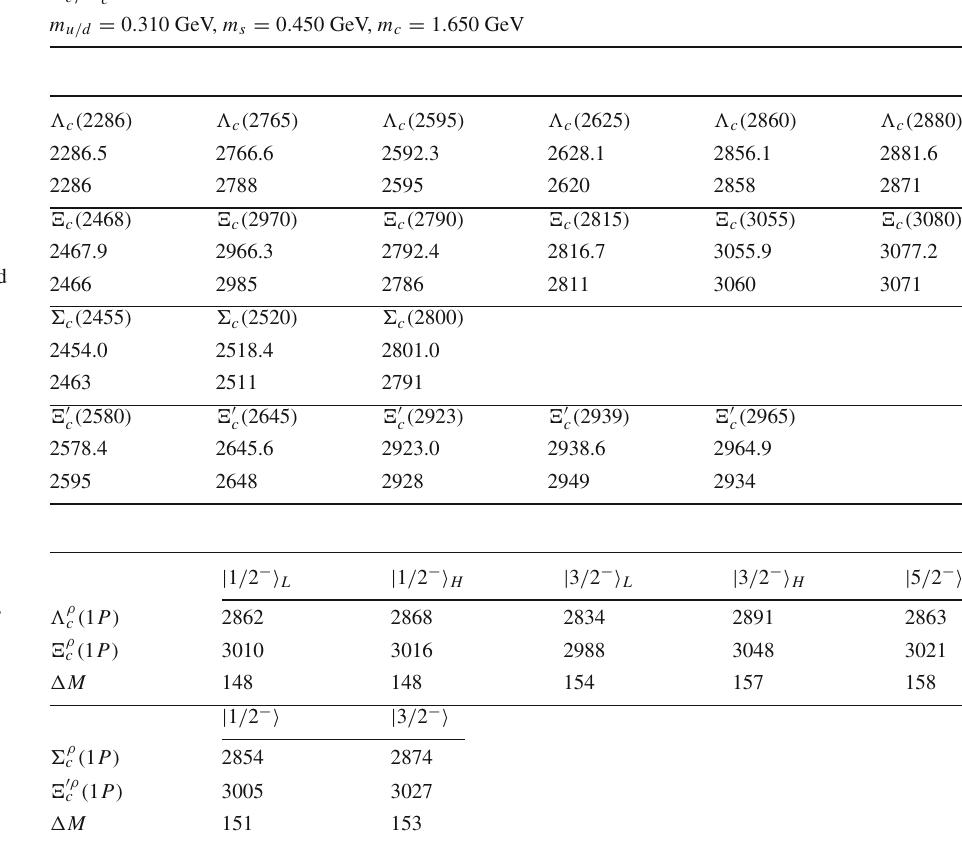
Table 5 The parameters of non-relativistic quark potential model. The consistent quark masses are presented in the last row